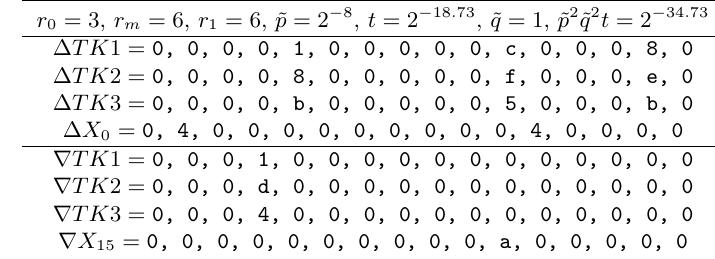
Table 23: The 15-round related-tweakey boomerang distinguisher for SKINNY-64-192